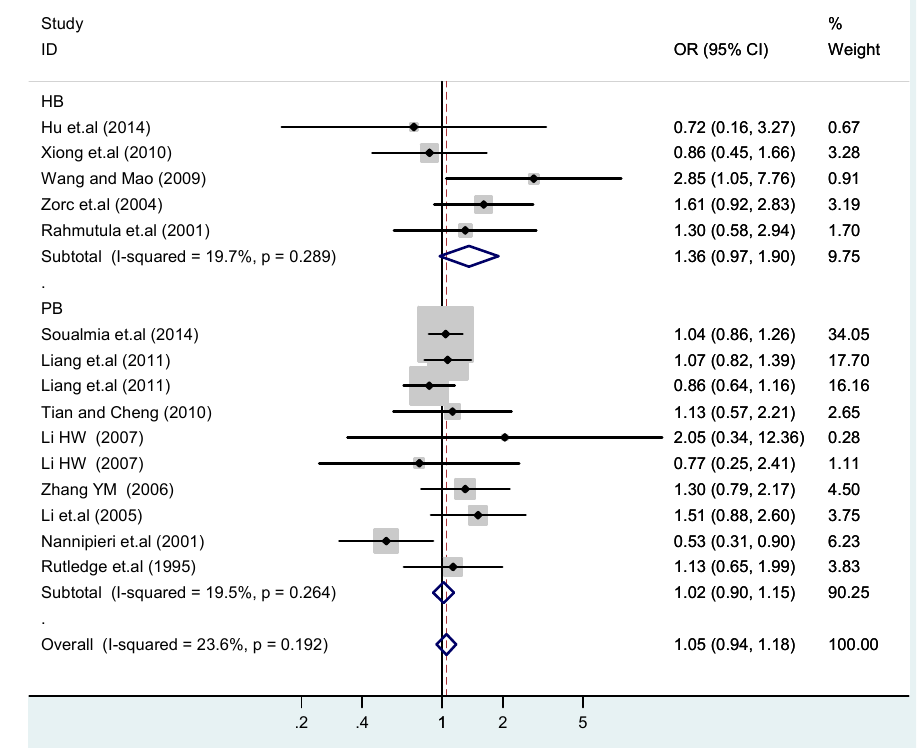
Figure 14. Subgroups in sources of controls of T2238C additive model (C vs. T).